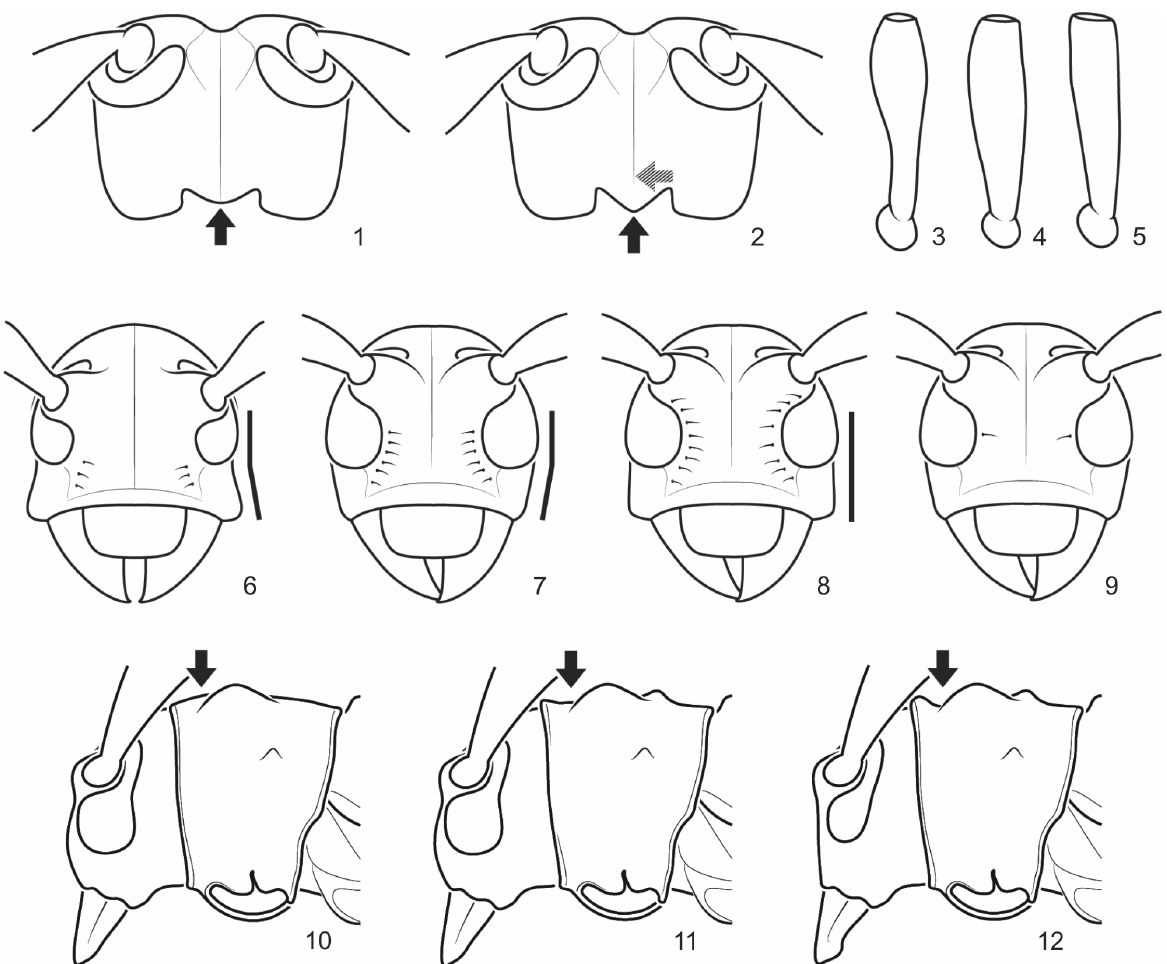
Figures 1–12. Schematic representation of the character states used in the cladistics analysis of Ateralphus and related genera, Alphus and Exalphus . 1–2, head in dorsal view: 1, Ateralphus subsellatus , posterior margin rounded (1:0; black arrow) and coronal suture reaching posterior margin (2:1); 2, Exalphus leuconotus (Thomson, 1860), posterior margin triangular (1:1; black arrow) and coronal suture reaching posterior margin (2:0; striped arrow). 3–5, shape of scape: C3, A. albitarsis , scape piriform (9:0); 4, A. subsellatus , scape gradually expanded toward apex, reaching the widest diameter at one third from apex (9:1); 5, Ateralphus variegatus , scape gradually expanded toward apex, reaching the widest diameter near the apex (9:2). 6–9, head in frontal view: 6, A. albitarsis , row of setae reaching the base of the lower ocular lobes (5:0) and genae divergent toward apex (8:0); 7, A. subsellatus , row of setae reaching the basal half of the antennal tubercles (5:1) and genae convergent toward apex (8:2); 8, E. leuconotus , row of setae reaching the antennal tubercles (5:2) and genae parallel (8:1); 9, Cotyzineus bruchi , only one seta at half of the lower ocular lobes (5:3). 10–12, prothorax in lateral view (character states are indicated by black arrow): 10, Alphus tuberosus (Germar, 1824), pronotum straight near anterior margin (16:0); 11, A. subsellatus , pronotum slight depressed near anterior margin (16:1); 12, E. leuconotus , pronotum deeply depressed near anterior margin (16:0).